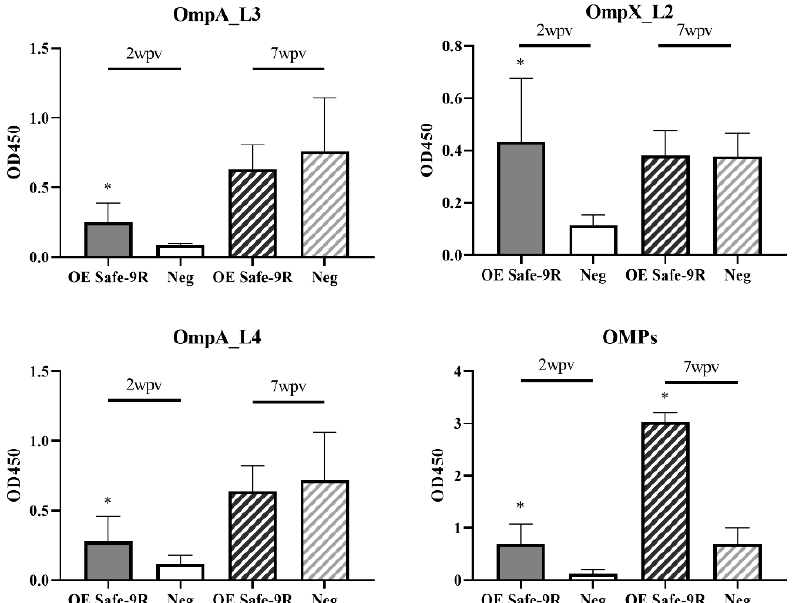
Figure 3. Humoral immune responses of the OE Safe-9R vaccines. Each group received OE Safe-9R at 1 week of age, and serum samples were collected at 2 weeks post-vaccination (wpv) and 7 wpv, respectively. The immune response was analyzed by ELISA made by Salmonella enterica serovar Gallinarum biovar Gallinarum (SG) immunogenic outermembrane proteins (OMP), OmpA and OmpX, and total OMP extracts. * Indicates a significant difference compared with Neg ( p < 0.05).